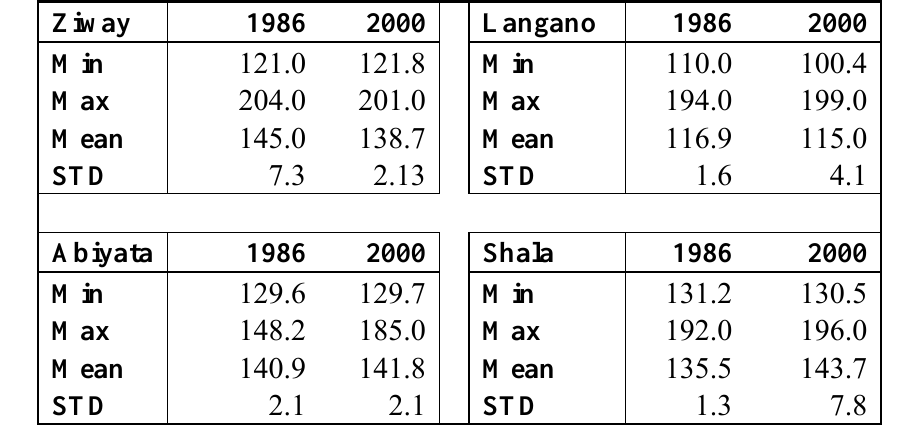
Table 3. Monthly lake evaporation statistics (mm)